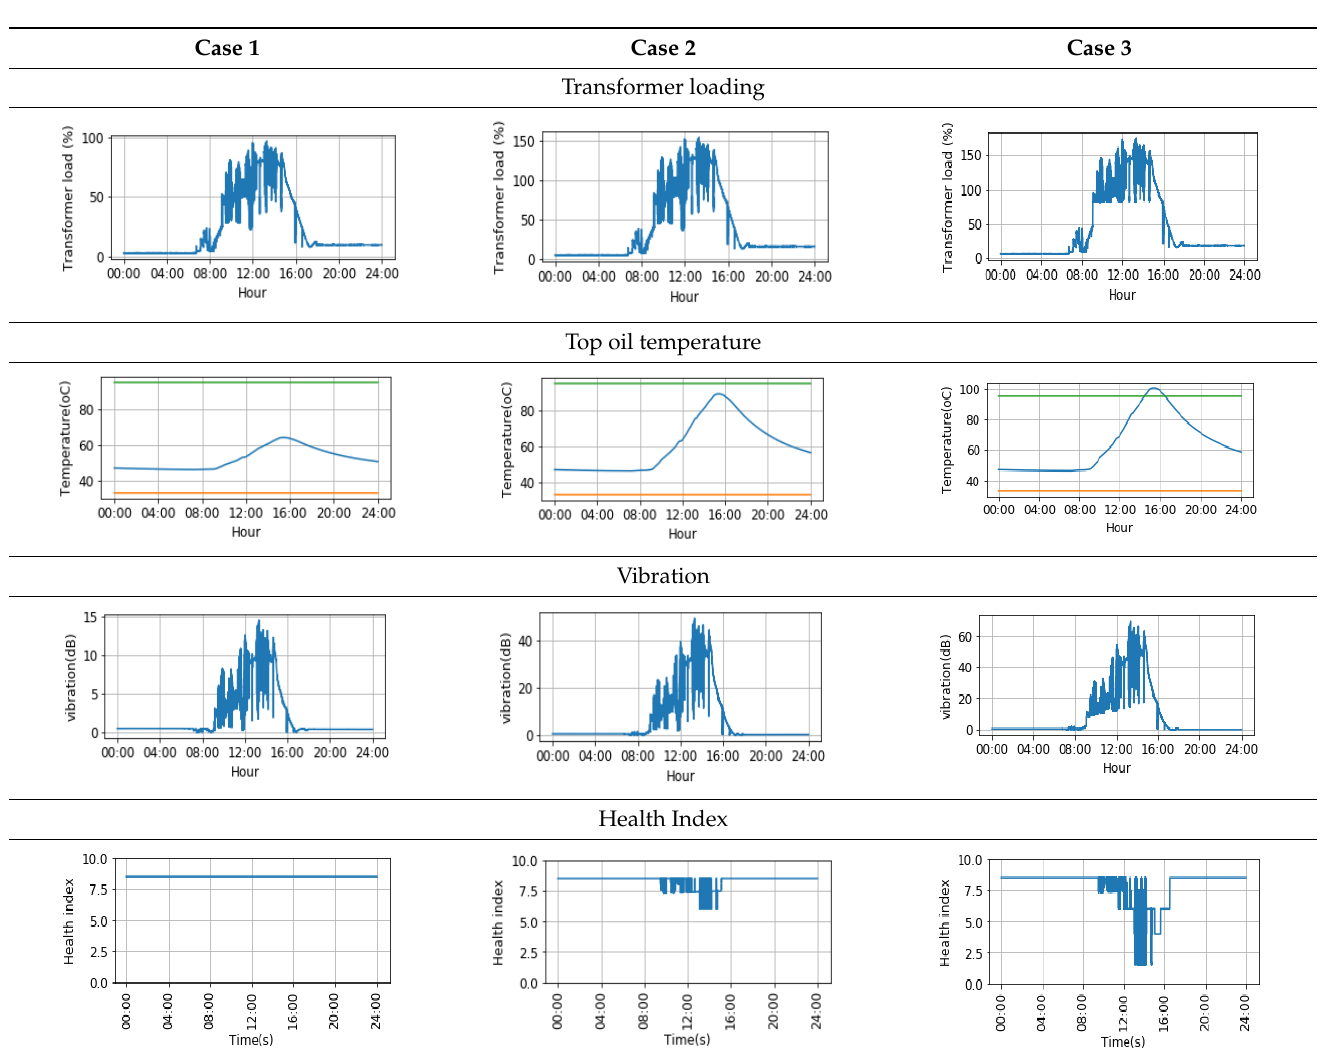
Table 3. Test results of scenario 1.